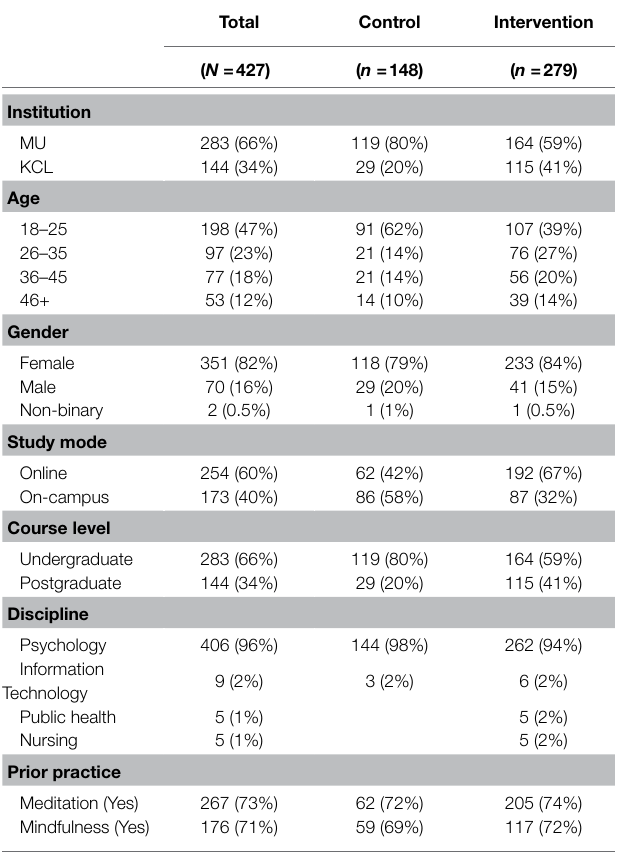
TABLE 1 | Participant characteristics as a percentage of the sample. Total